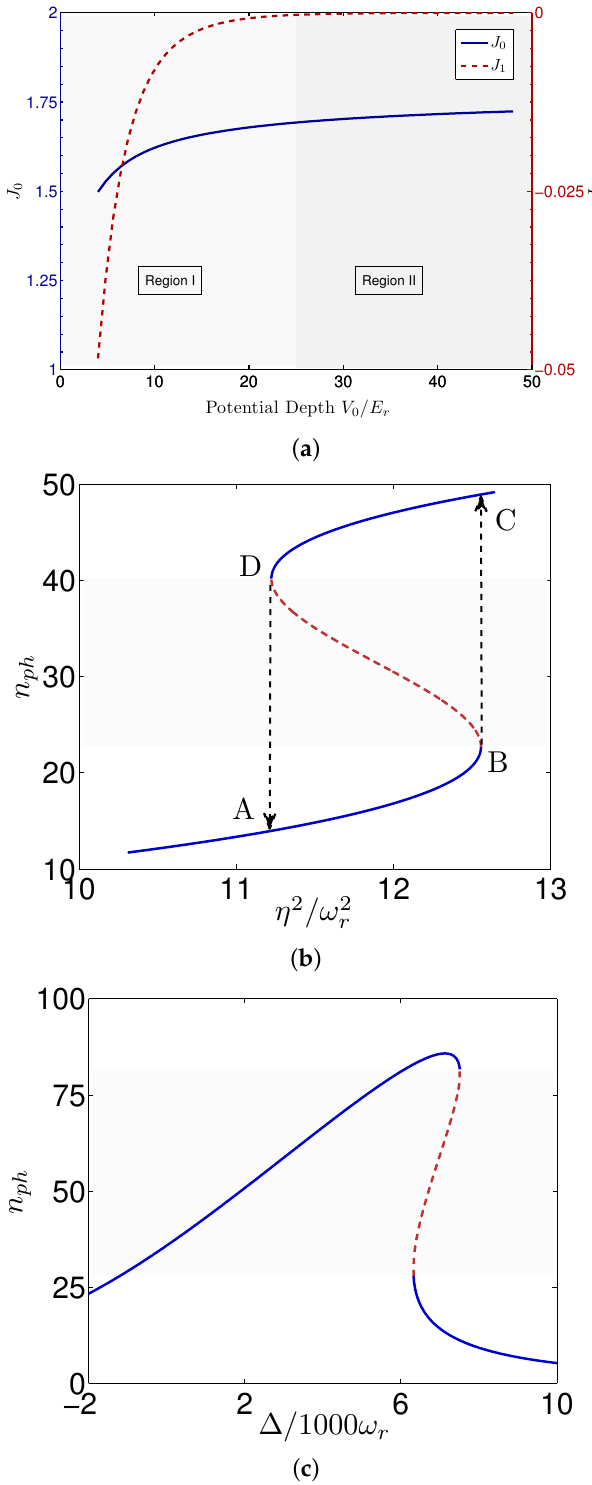
Figure 10. ( a ) The variation of overlap integral elements with potential depth. We study the variation in two regions, which are (arbitrarily) separated at V = 25 E r ; we have used a 6 × 6 lattice, { U 0 , κ } = { 12,1 } ω r ; ( b ) with pump amplitude η for ∆ c = 5000 ω r ; ( c ) with detuning ∆ c for η = 6 ω r . The red dotted lines are the unstable regions of photon count. From [34]. (Reprinted figures with permission from Padhi, B.; Ghosh, S. Phys. Rev. A 2014, 90, 023627. Copyright (2014) by the American Physical Society. Source: